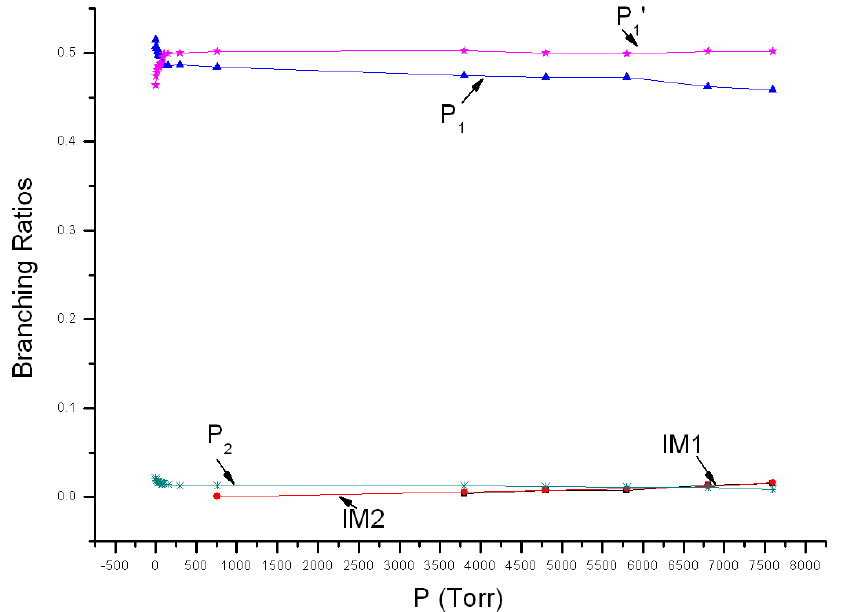
Figure 4. Branching ratios of various reaction channels at 213 K in a pressure range from 1 Torr to 7600 Torr.